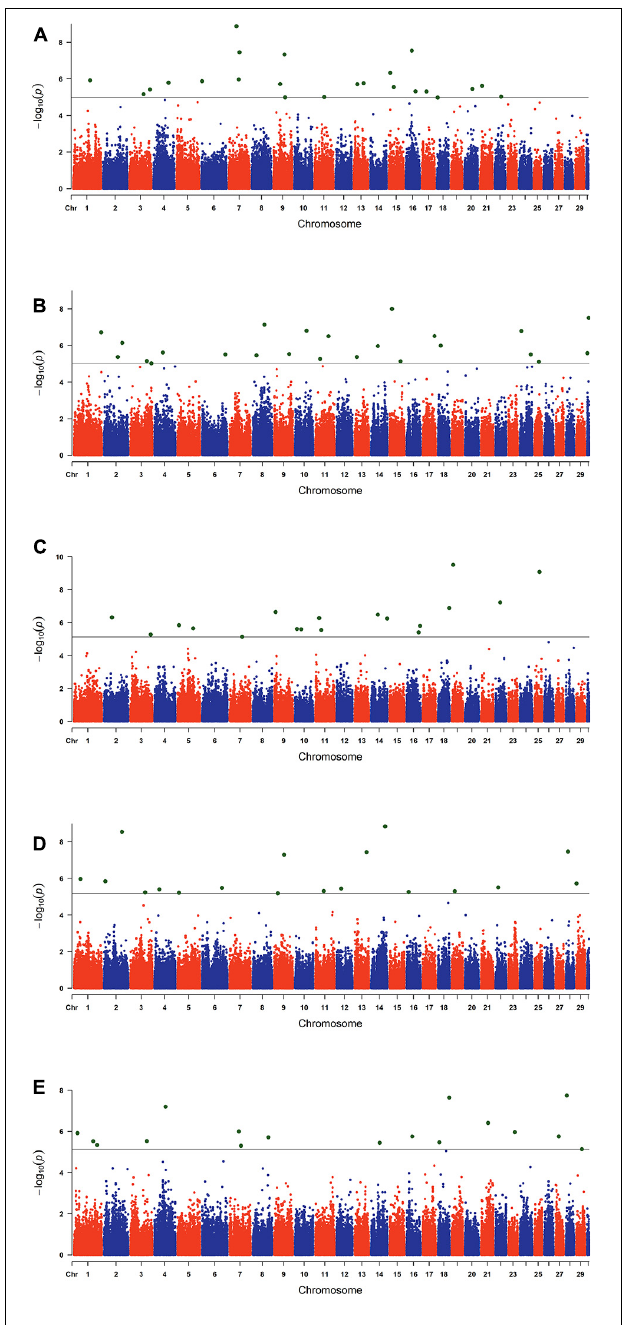
FIGURE 2 | Manhattan plots of the genome-wide association studies for genetic effect of service sire on reproductive traits. The x -axis and the y -axis represent the chromosome number and the observed − log 10 ( P − value ) , respectively. The single-nucleotide polymorphisms were plotted against their genomic positions. The lines in the plots indicate the thresholds of false discovery rate (0.05) in the corresponding traits: (A) conception rate, (B) 56-day non-return rate, (C) calving ease, (D) stillbirth, and (E) gestation length.